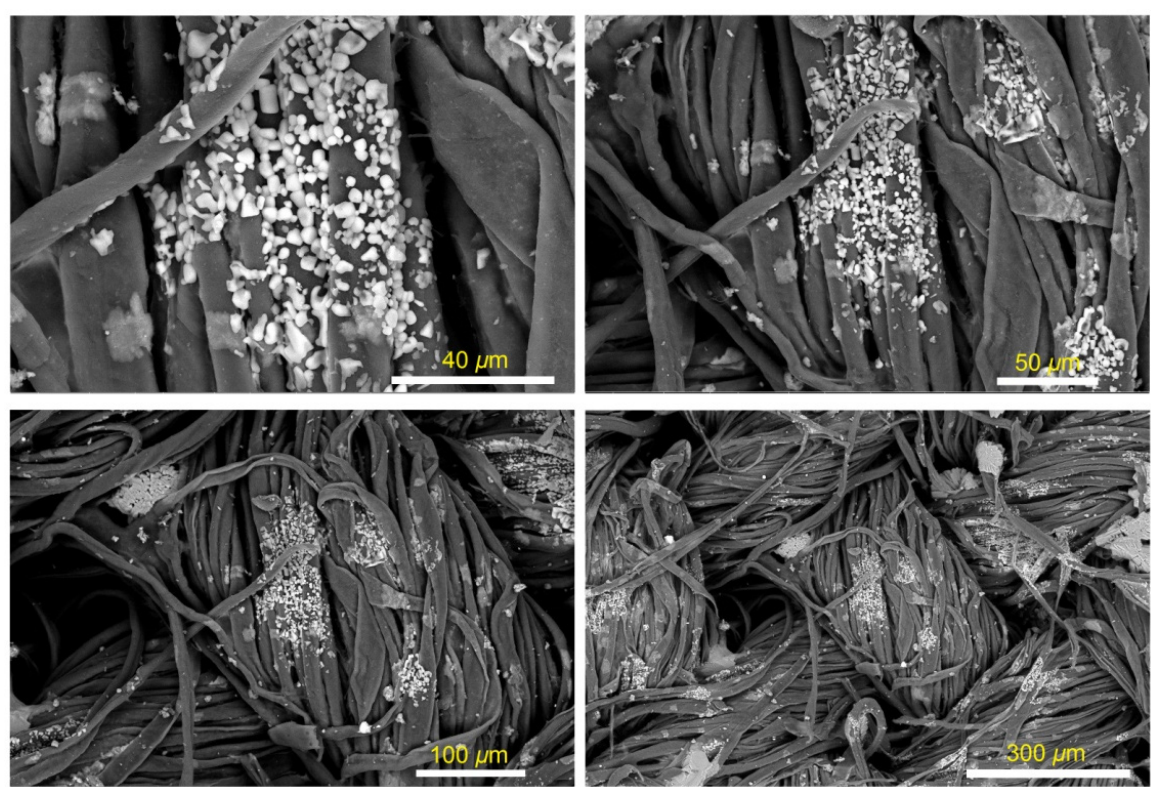
Figure 1. SEM micrographs of spray-coated cotton fibers (S 8 ) at different magnifications.